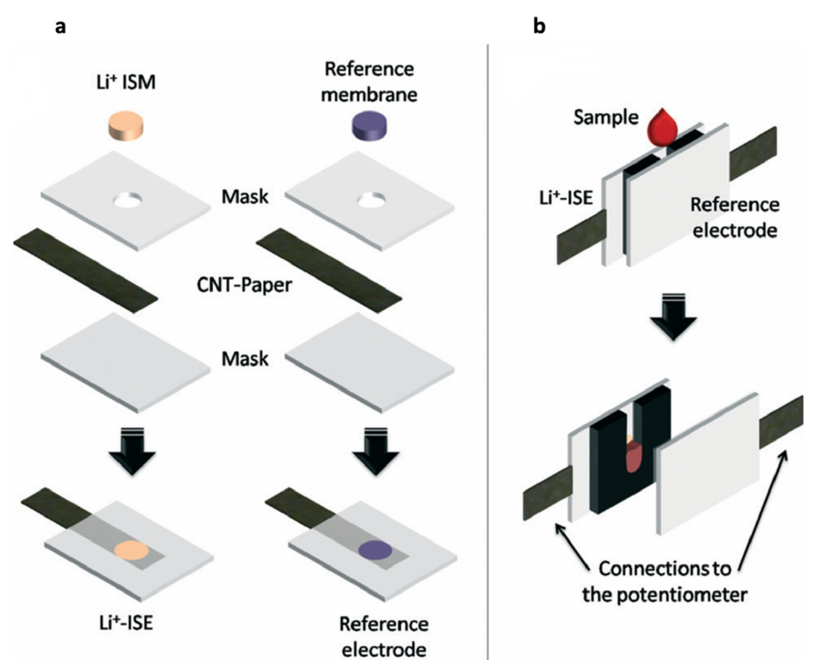
Figure 8. Paper-based potentiometric cell for decentralized monitoring of lithium levels in whole blood. ( a ) A scheme of the paper electrodes. ( b ) A scheme of the completed measuring setup (modified with permission from Novell et al., Lab on a Chip , 2014 [15]).